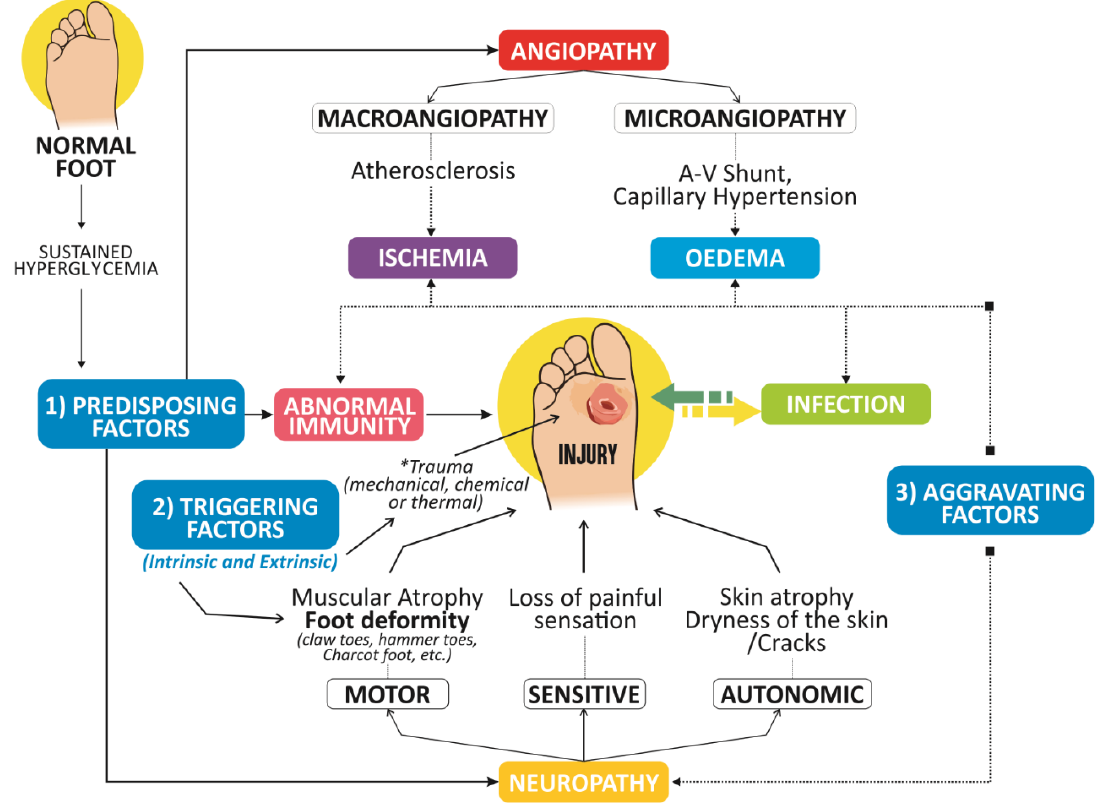
Figure 1. Risk factors and predisposing factors for the development of diabetic foot ulcers (DFUs). There are two main protagonists among the risk factors and / or predisposing factors of DFUs: angiopathy and neuropathy, whose presence, together with intrinsic (foot deformity) and / or extrinsic triggers, such as trauma (mechanical, chemical or thermal), causes the loss of skin integrity. Aggravating factors, such as ischemia, abnormal immunity, and neuropathy, favor the development of DFU infections.